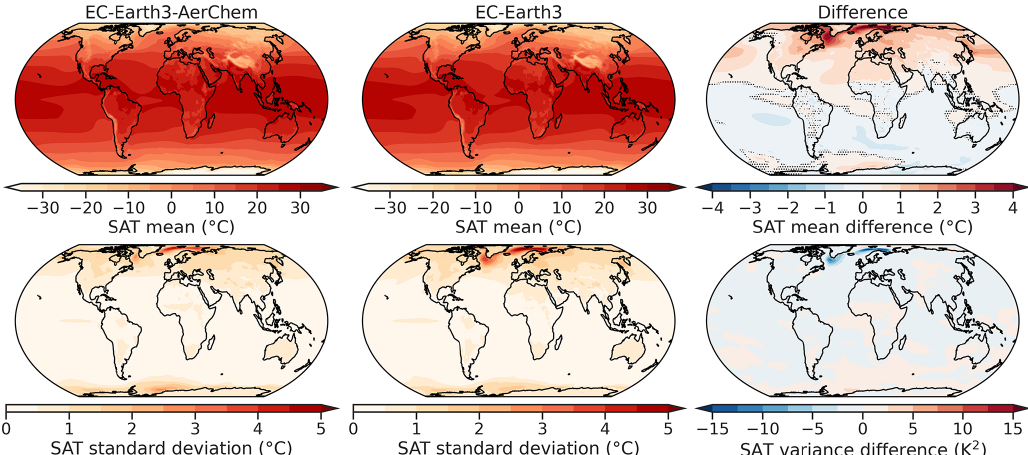
Figure 3. Mean and interannual standard deviation of the surface air temperature (SAT) in the Earth3-AerChem and EC-Earth3 preindustrial control simulation. The panels on the right show the corresponding differences in the mean and interannual variance in EC-Earth3-AerChem compared with EC-Earth3. The stippled areas in the top-right panel indicate the regions where the differences are not significant at the 5% level, as determined from a two-sided unequal variances independent t